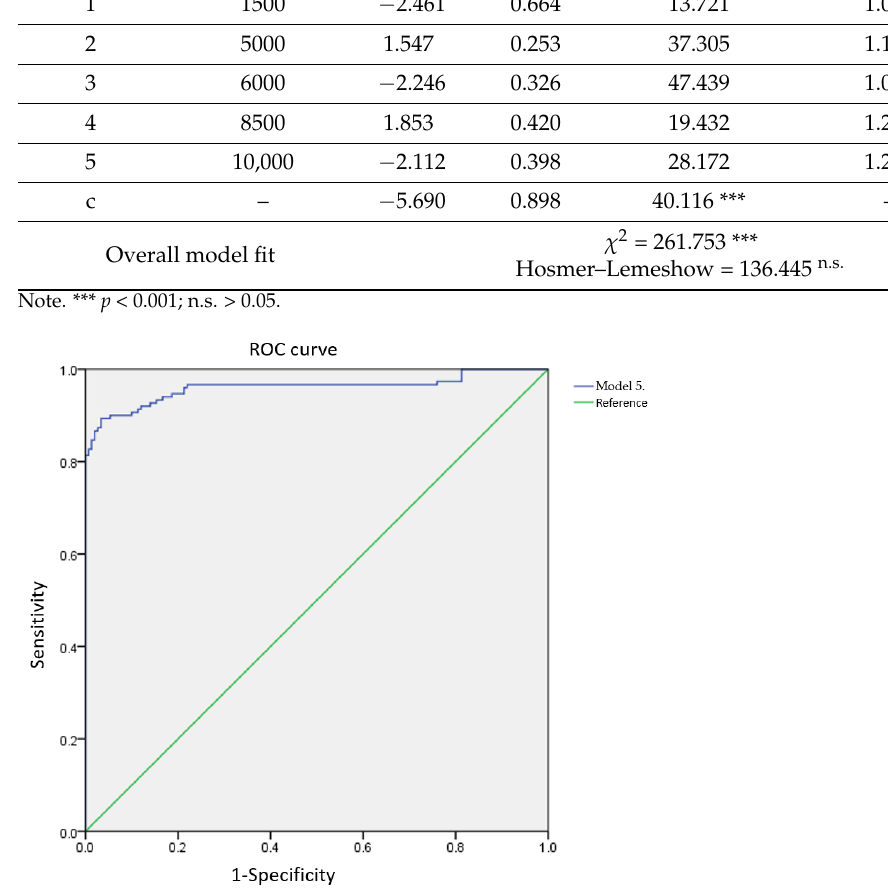
Figure 4. Model 5 receiver operating characteristic (ROC) curve for the calibration group.